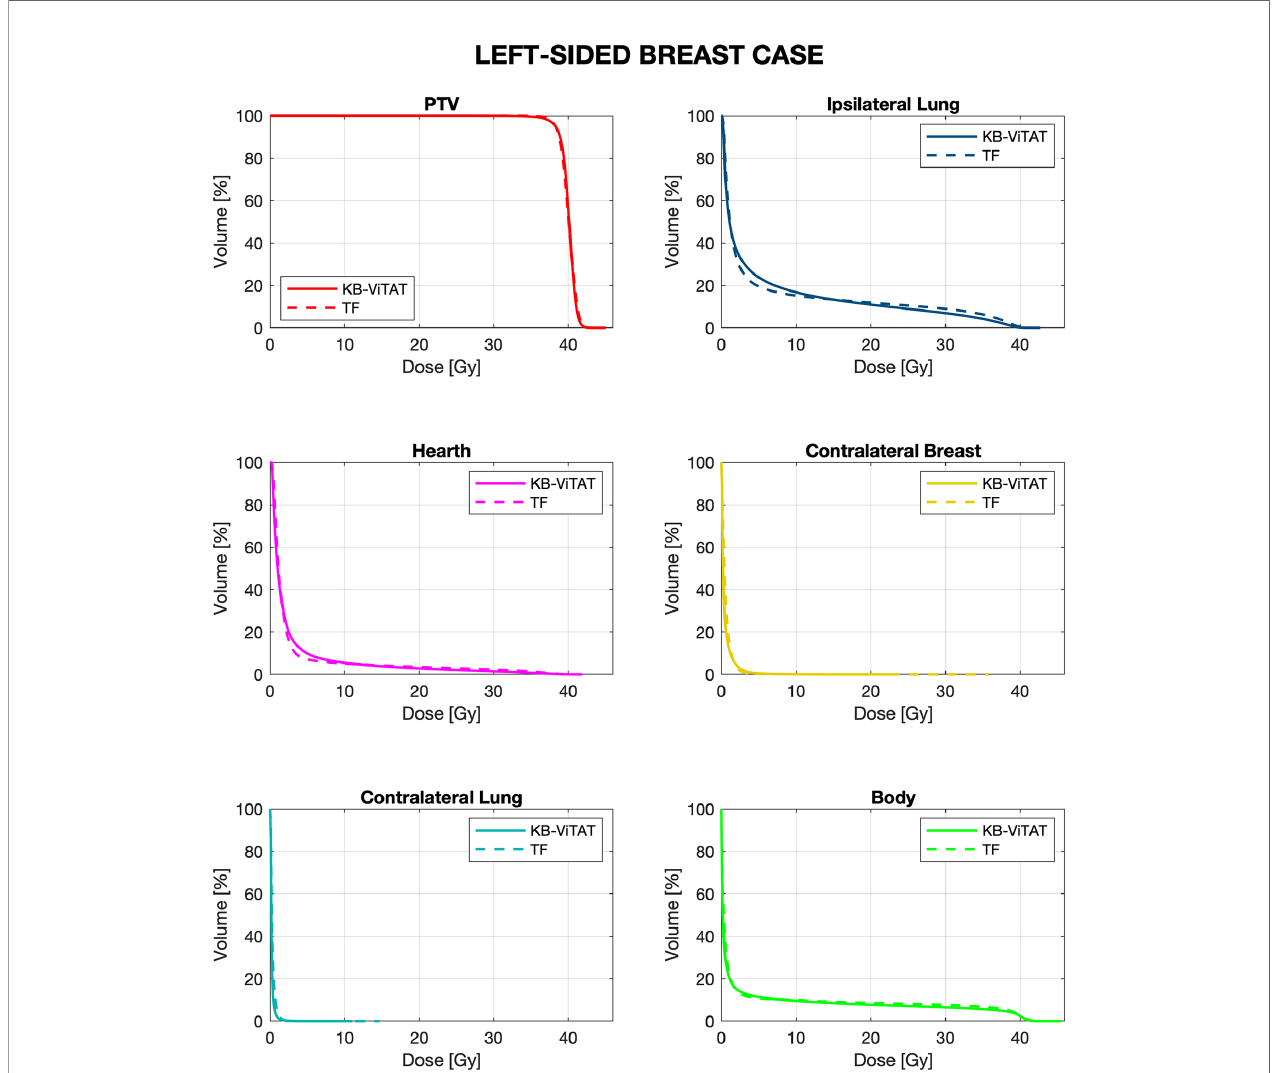
FIGURE 3 | Mean-DVH comparison of 30 left-sided breast patient tests between the original clinical TF (solid lines) and fully automatic KB-ViTAT (dashed lines)